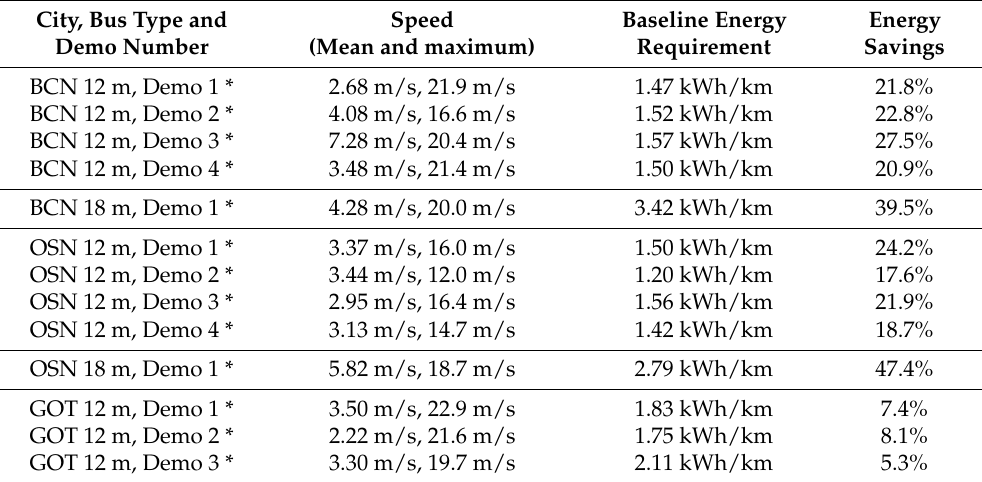
Table 4. Energy reduction possible due to